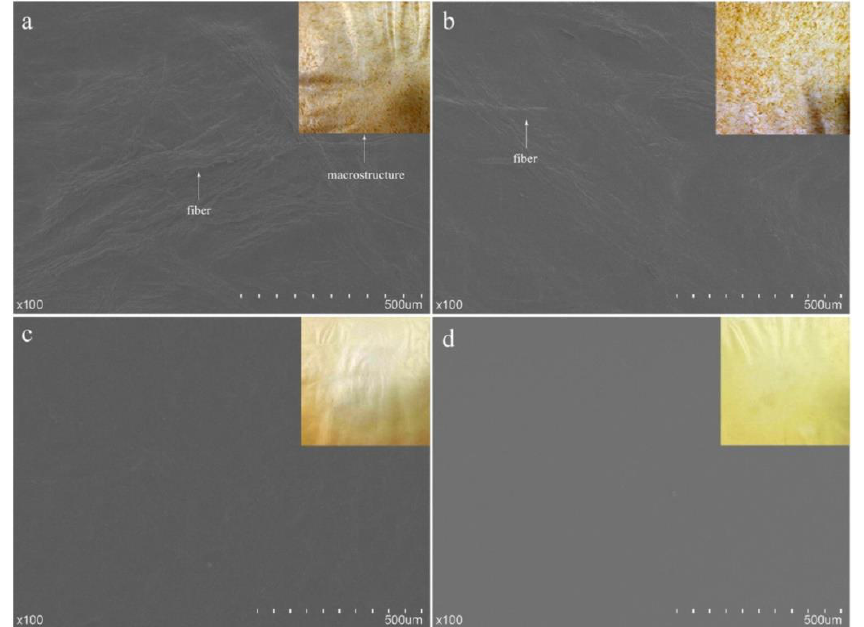
Figure 8. SEM images of surface morphology of film composed of different Flammulina vellutipes insoluble fibers prepared using ( a ) Colloid Mill (CM); ( b ) PFI Mill (PFI); ( c ) Low Pressure Homogenization (LPH); ( d ) High Pressure Homogenization (HPH), along with corresponding photographs. Reproduced with permission from [35]. Copyright 2018 Elsevier.